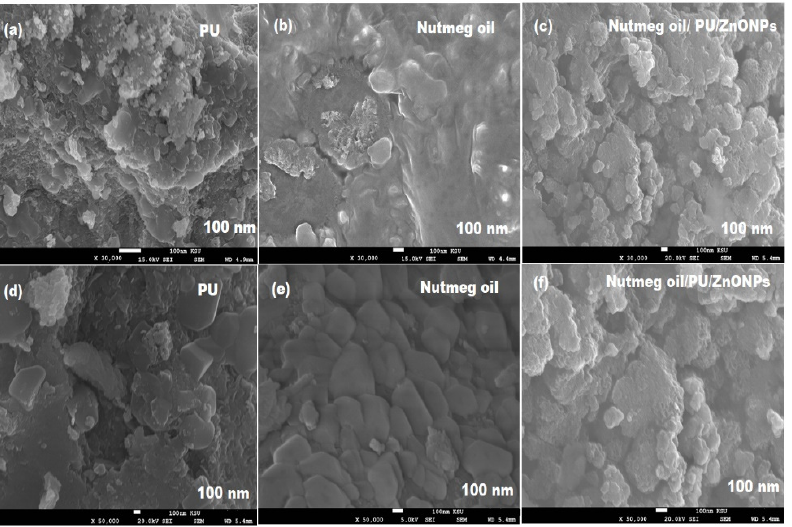
Figure 6. SEM images of ( a , d ) plain PU, ( b , e ) nutmeg oil, and ( c , f ) nutmeg oil/PU/ZnNPs bionanocomposite at ×30,000 and ×50,000 magnification.